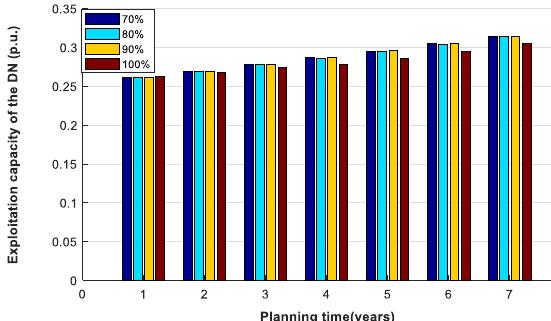
Figure 9. Annual variation of the exploitation capacity of the network in the four scenarios analyzed. Table 12. Fixed cost of the planning solutions for each scenario proposed.